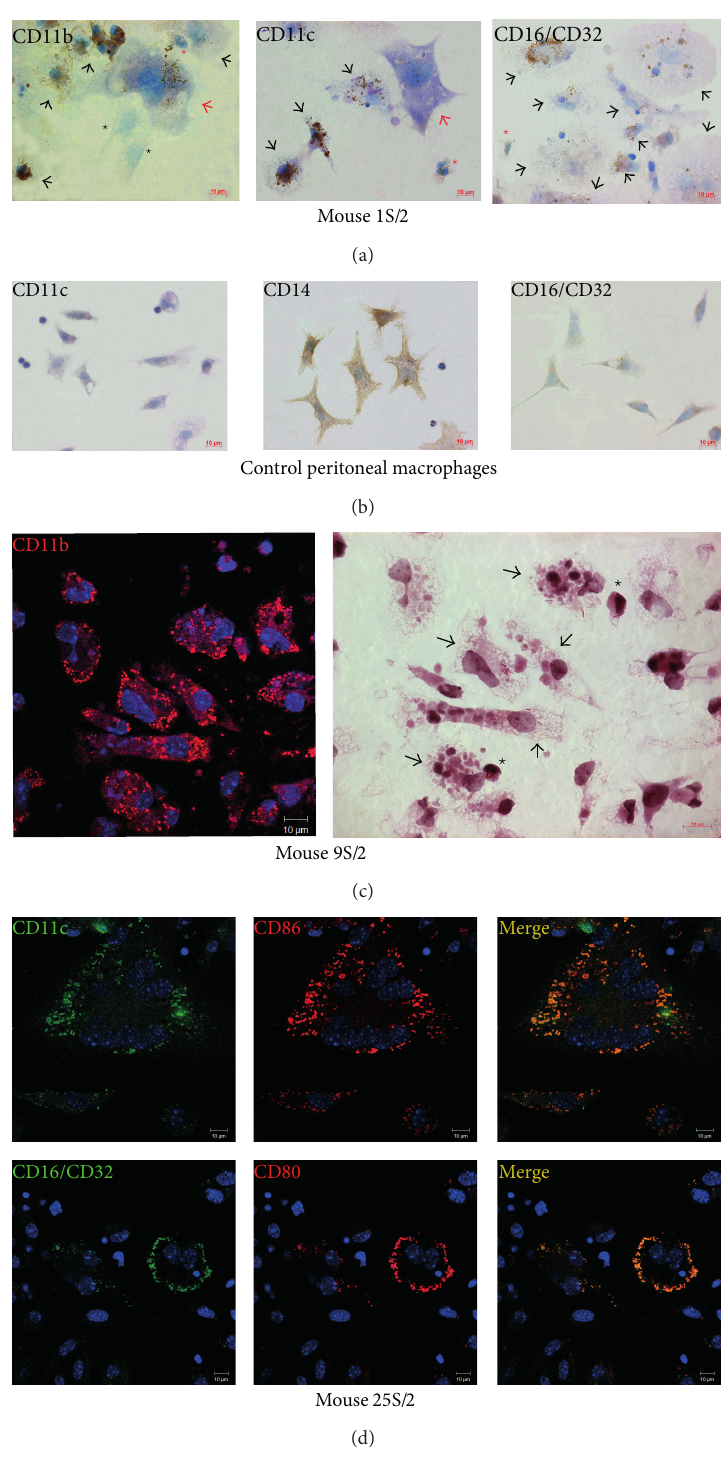
Figure 3: The phagocytic receptors and the costimulatory molecules on granuloma cells from the spleens (S/) of mice that were infected with the BCG vaccine in vivo for two months (/2) and after ex vivo culture for a few days. Scale bars: 10 𝜇 m. Different parts of granulomas are shown. ((a)-(b)) The immunochemical localization of the leukocyte surface markers CD11b, CD11c, CD14, and CD16/CD32 on granuloma cells and control mouseperitoneal macrophages, respectively. Thebrown color of the cell membranes indicates thepresence of thereceptors in these regions. Black and red arrows indicate macrophages and megakaryocytes stained for cell surface markers, respectively; red stars indicate neutrophilsspecificallystainedforthereceptors;blackstarsindicatefibroblastswithouttheantigen.((c)-(d))Theconfocalimmunofluorescent localization of the cell surface receptors CD11b (red signal), CD11c and CD16/CD32 (green signals), and CD80 and CD86 (red signals) in granuloma cells. Colocalization of the receptors on confocal images of cells (yellow signal). Staining nuclei with DAPI (blue signal). (c) On the right panel is the same granuloma part that is on the left panel, but it is restained to acid-fast BCG-mycobacteria by Ziehl-Neelsen method. Macrophages and dendritic cells with BCG-mycobacteria are indicated by black arrows and stars, respectively. ((d), top panels) A part of a granuloma with a Langhans giant